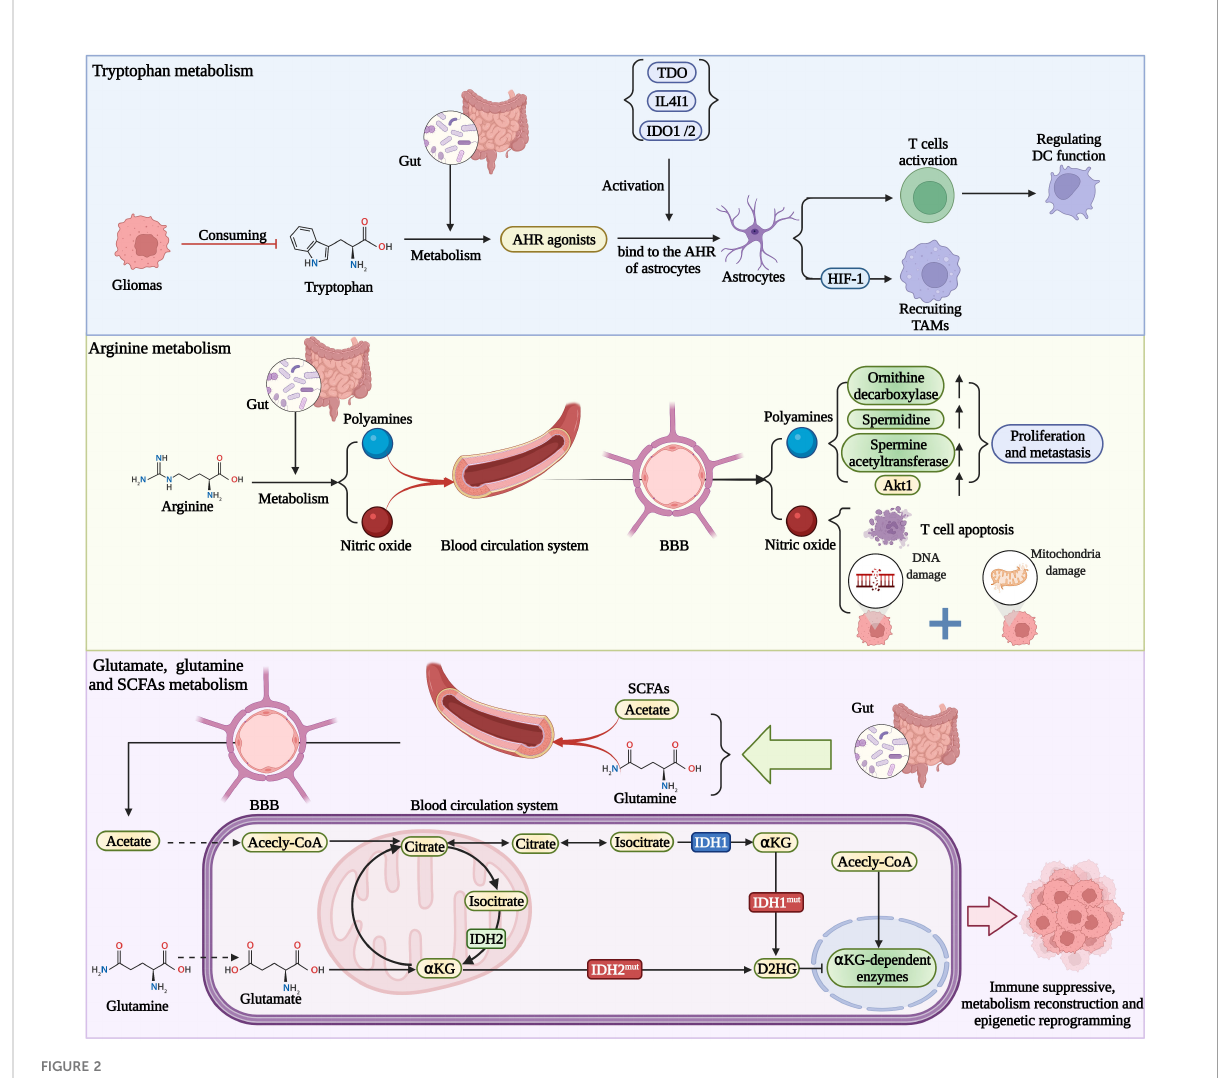
FIGURE 2 Gut metabolites affect the functions of immune cells and glioma immune microenvironment, which shapes the immune state into the suppressive type. Metabolites also change the epigenetic landscape of glioma cells, then altering the behavior of